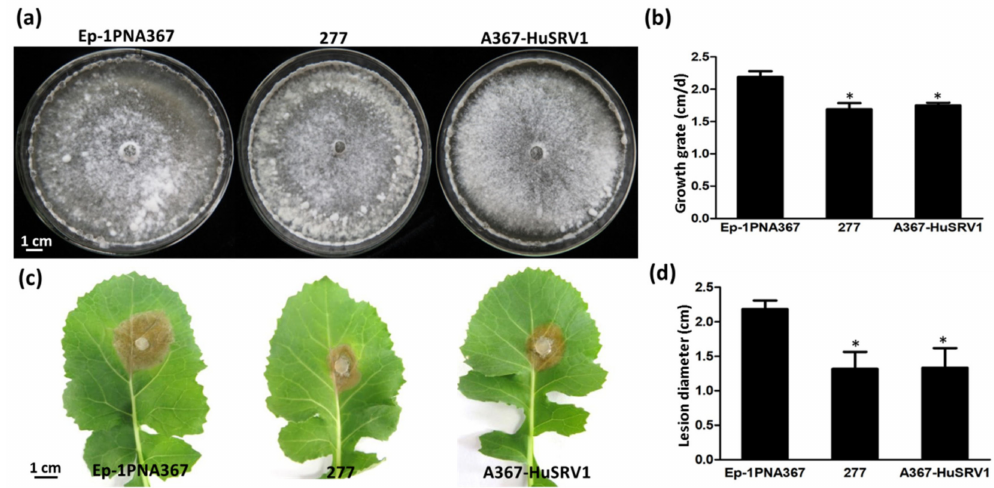
Figure 1. Biological characteristics of strains Ep-1PNA367 and 277, and of transfected strain A367-HuSRV1. ( a ) Colony morphology of strains Ep-1PNA367, 277 and A367-HuSRV1 grown for 7 days on PDA at 20 ◦ C. ( b ) Growth rates of strains Ep-1PNA367, 277, and A367-HuSRV1. ( c ) Pathogenicity assay of three strains on detached rapeseed leaves at 48 hpi, 20 ◦ C, and approximate 100% relative humidity. ( d ) Comparison of lesion diameters produced by these strains on detached rapeseed leaves. Statistical analysis was performed using one-way ANOVA followed by Dunnett’s multiple range test. Asterisks (*) on top of the bars represents significant di ff erences when compared with Ep-1PNA367 ( p < 0.01) based on multiple comparison